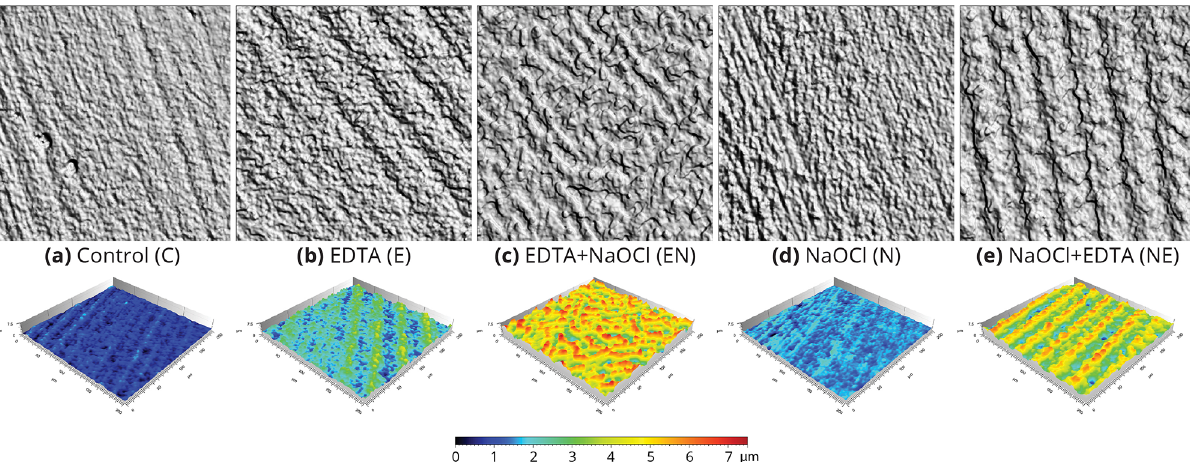
Figure 2. Surface image (top) and surface topography (bottom) of the dentin surfaces following the irrigation protocols. A 160 × 160 μm image was acquired using a high-resolution confocal disc-scanning measuring system (100 × long distance lens, μsurf Explorer; NanoFocus AG). ( a ) Control; ( b ) EDTA 17%; ( c ) EDTA 17% followed by NaOCl 5.25%; ( d ) NaOCl 5.25%; ( e ) NaOCl 5.25% followed by EDTA 17%. Note the reduced roughness of the control ( a ) and NaOCl 5.25% ( d ) groups compared to the other treatments ( b , c , e ). The color map indicates the measured height in micrometers above the lowest point for each surface.